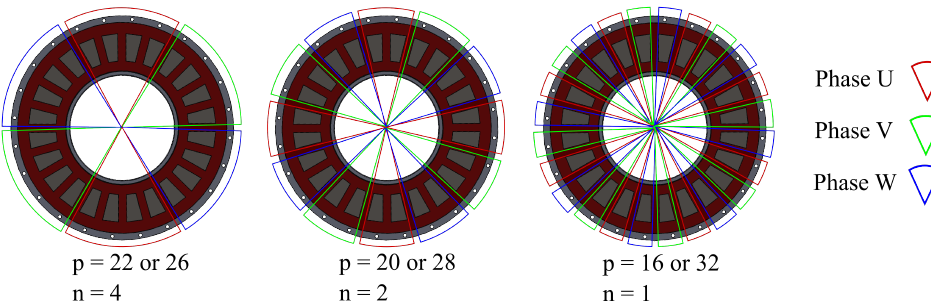
Figure 3. Winding diagrams and the number of adjacent coils belonging to the same phase n for the feasible slot/pole combinations from Table